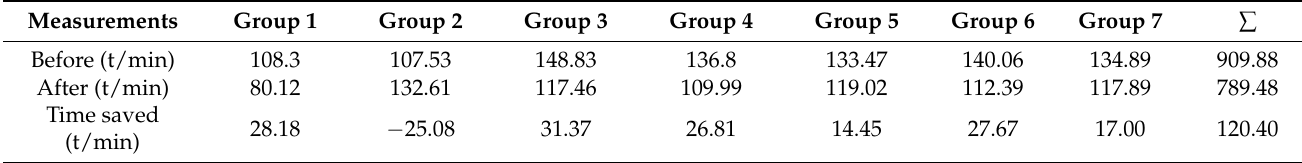
Table 11. Total aircraft ground handling times of selected aircraft